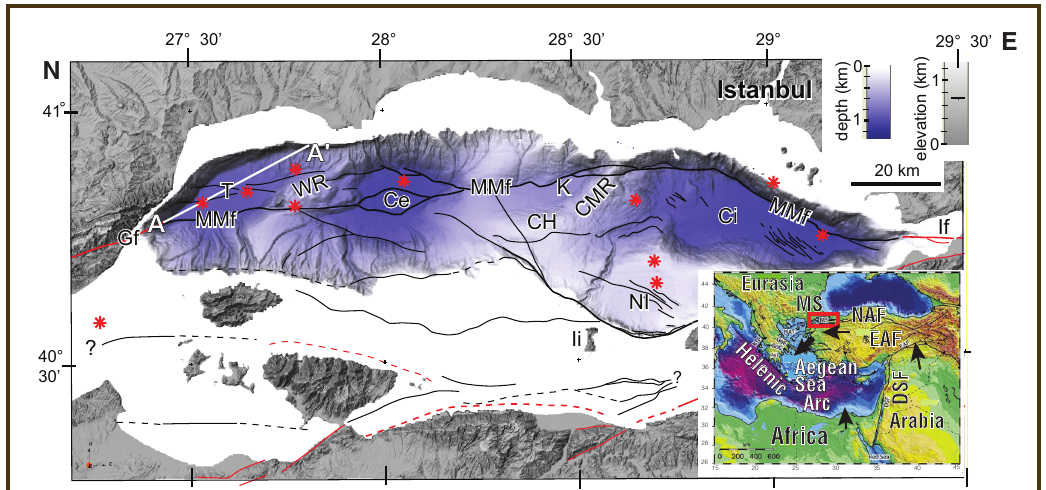
Figure 1. Bathymetry and topography of the Marmara Sea region (bathymetric data from Rangin et al., 2001) showing its basins from east to west: Cinarcik (Ci), North Imrali (NI), Kumburgaz (K), Central (Ce), Tekirdag (T). These basins are separated by the Central Marmara Ridge (CMR) and Western Ridge (WR). The main faults are shown as black lines (Sorlien et al., 2012); those in red are from several published sources as explained in Sorlien et al. (2012): Izmit fault (If), Main Marmara fault (MMf), and Ganos fault (Gf). The red stars mark the locations of the proposed drill sites. Inset shows the topography of the eastern Mediterranean with plate tectonic configuration and GPS-derived vectors (Reilinger et al., 2010). Red box locates Marmara Sea. Also shown are the North Anatolia Fault (NAF), East Anatolia Fault (EAF) and Dead Sea Fault